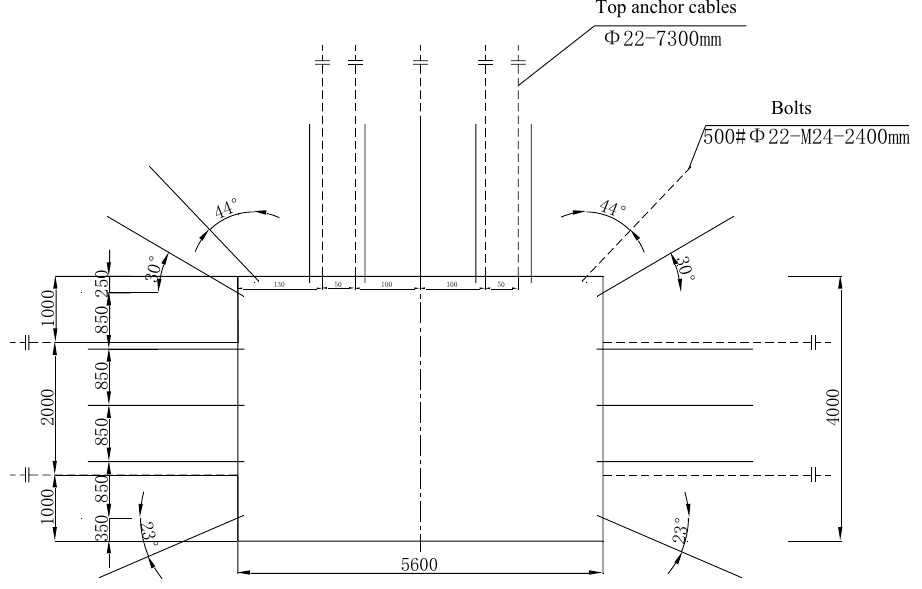
Figure 1. Support scheme of the air inlet roadway in 2603 working face.